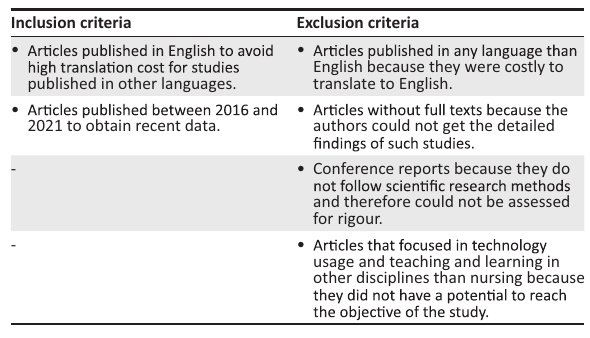
FIGURE 2: PRISMA flow diagram. FIGURE 3: Inclusion and exclusion